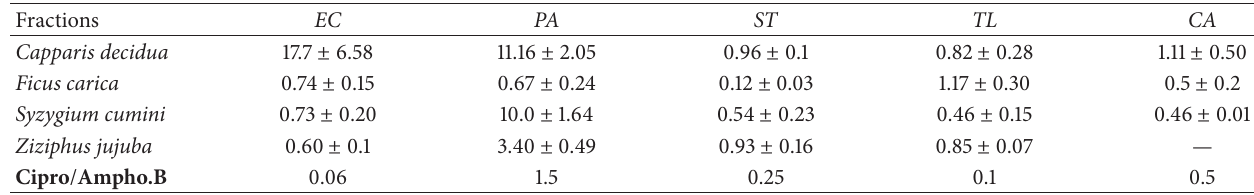
Table 5: Antimicrobial (antifungal and antibacterial) assay at 5 mg/mL of methanolic crude extracts of selected plants (average value ± SD, 𝜇 g/mL).